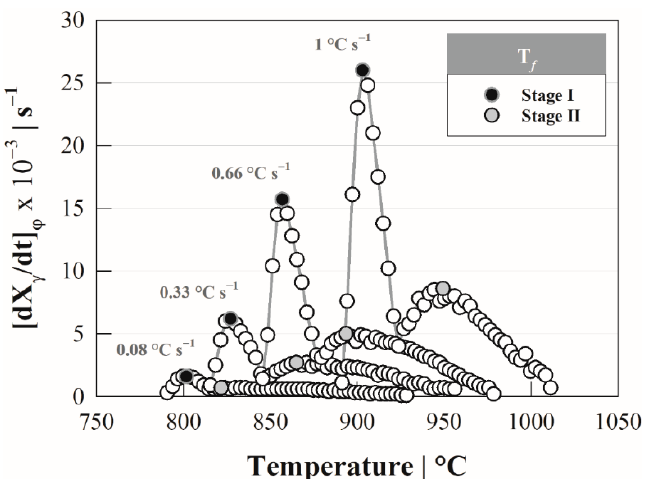
Figure 4. Austenite formation rate by stages as a function of heating rate: 0.08, 0.33, 0.66 and 1.00 °C s − 1 .